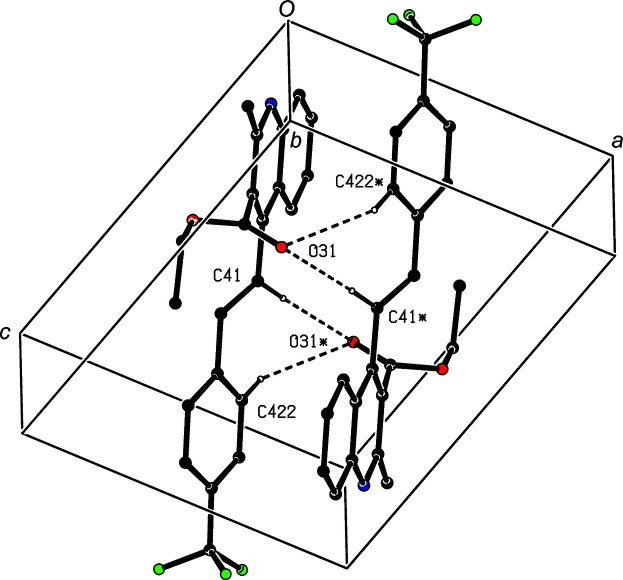
Part of the crystal structure of com­pound (VI), showing the formation of a centrosymmetric dimer. Hydrogen bonds are drawn as dashed lines and, for the sake of clarity, H atoms which are not involved in the motif shown have been omitted. Atoms marked with an asterisk (*) are at the symmetry position (−x + 1, −y + 1, −z + 1).